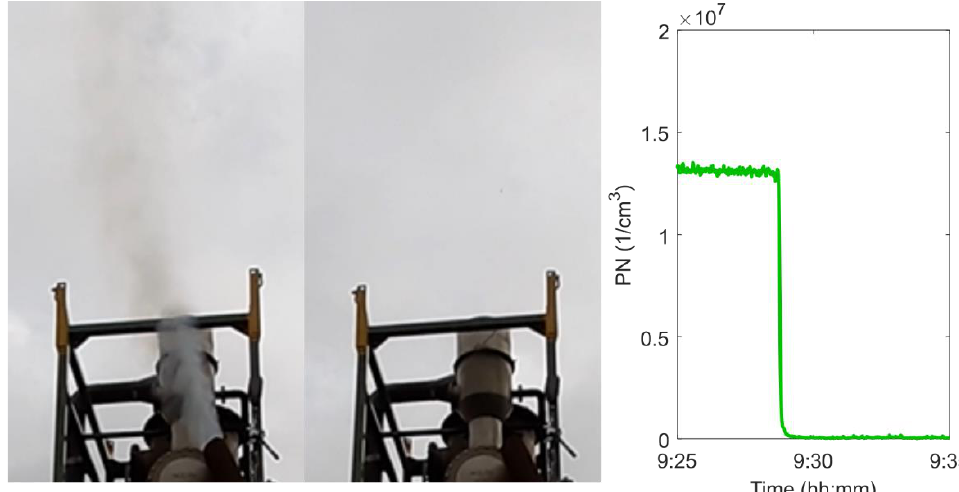
Figure 6. Effect of the WESP on visible smoke. The WESP was first off, and significant plume was seen ( left ). The plume vanished after the WESP was switched on ( middle ). The concentration of non-volatile >23 nm particles (PN) during the WESP startup is shown in the plot ( right ). Photos were taken from a same video.